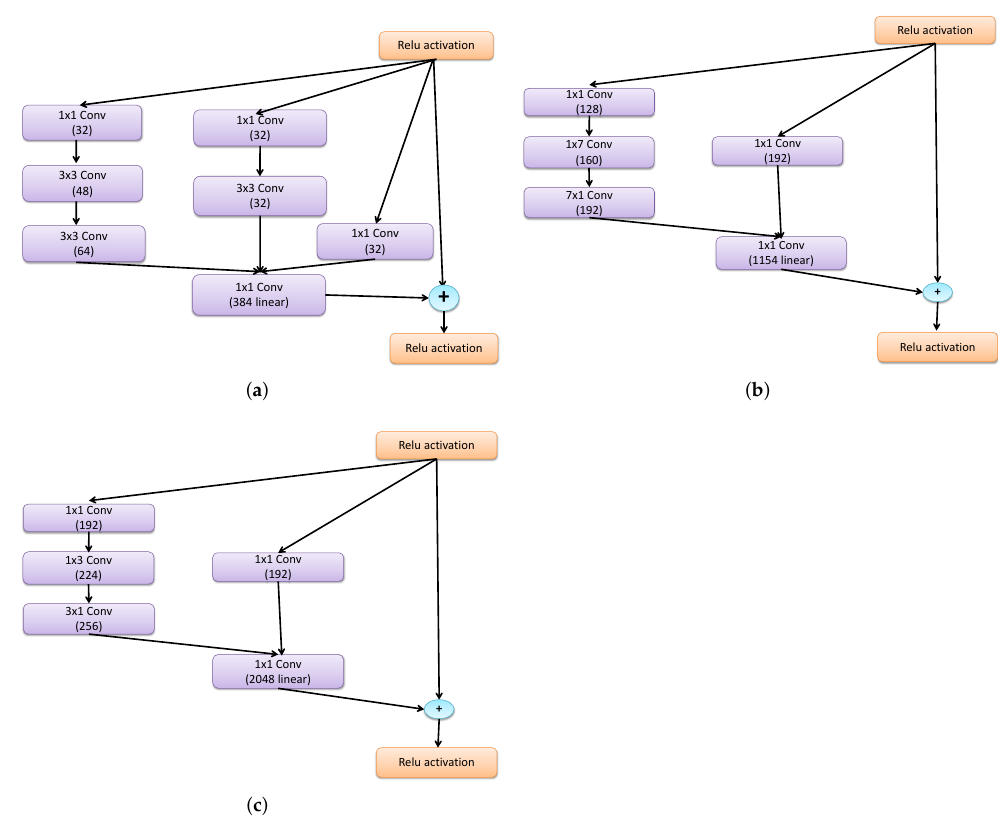
Figure 5. Overall architecture of the Inception-resnet modules. ( a ) Inception-resnet-A. ( b ) Inception- resnet-B. ( c ) Inception-resnet-C.